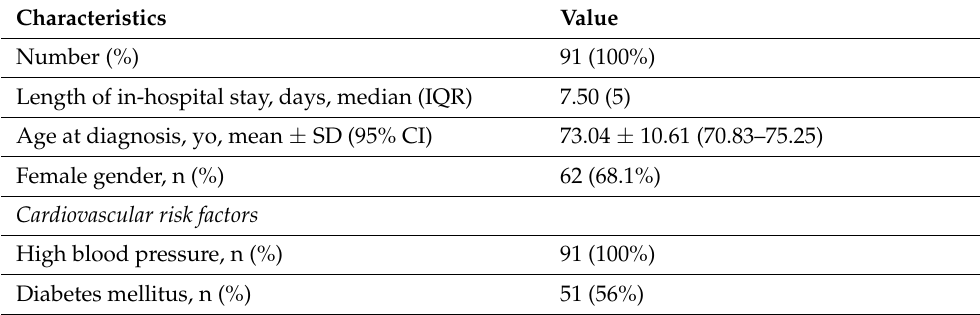
Table 1. Key baseline characteristics of the patients with Acute Heart Failure with preserved ejection fraction (HFpEF) (n = 91).